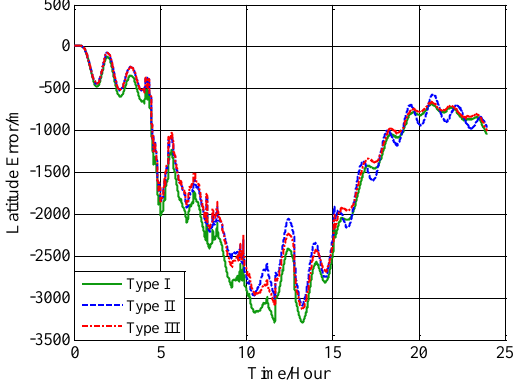
Figure 16. The comparison of the latitude error.